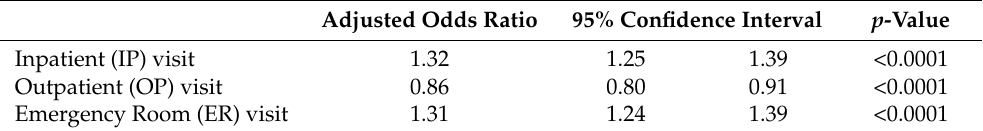
Table 3. Adjusted health visit